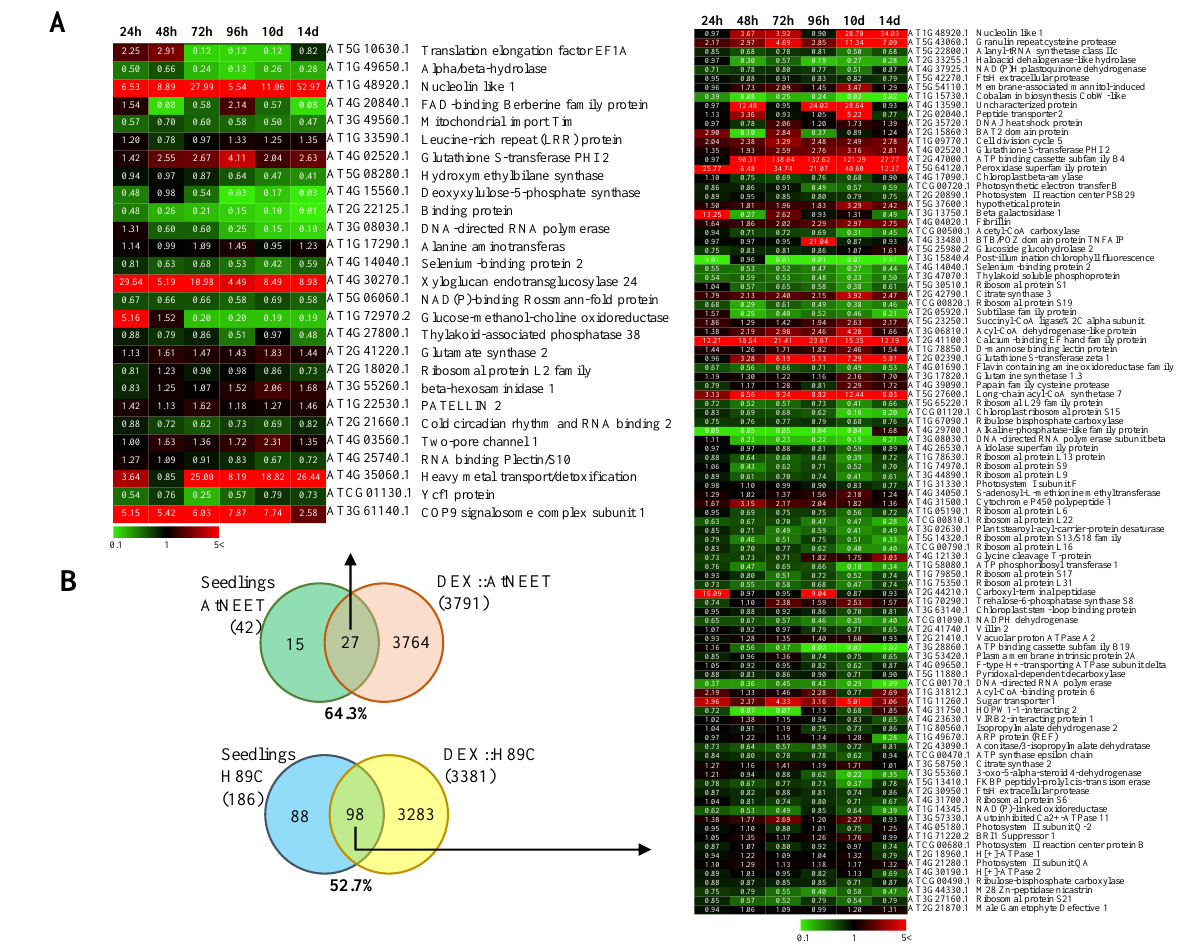
Figure 4. Comparison between the proteomics results obtained with the inducible expression system in this study and the results obtained with the constitutive expression of AtNEET and H89C. ( A ) Heat maps for the expression pattern of proteins shared between the two experimental systems. ( B ) Venn diagrams showing the overlap between the two experimental systems (inducible expression in mature plants vs. constitutive expression in seedlings). Proteomics results of constitutive AtNEET and H89C expression were obtained with permission from [9]. All experiments were repeated at least three times with similar results.